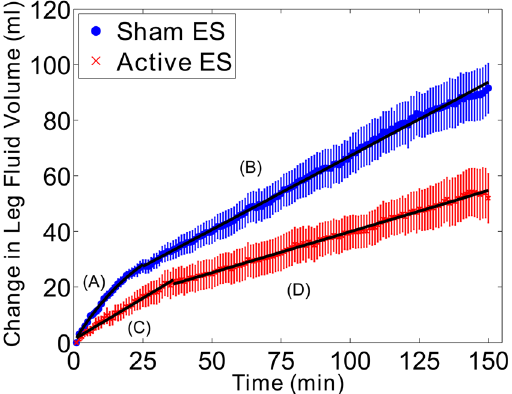
Figure 1. Mean change in leg fluid volume over the 150 minutes seated period in the active (red) and sham (blue) ES study conditions with standard error bars. Temporal pattern of fluid accumulation was different between the active and sham ES study conditions, with fluid accumulating more rapidly in sham ES study condition. The temporal patterns of fluid accumulation were also different between the initial and latter portions of sitting. The models representing the initial and latter portions of siting in both the active and sham ES conditions are described by equations A through D. A: LFV ( t ) = 34.0 (1 − e − 0.03 t ). B: LFV ( t ) = 0.53 t + 26.8. C: